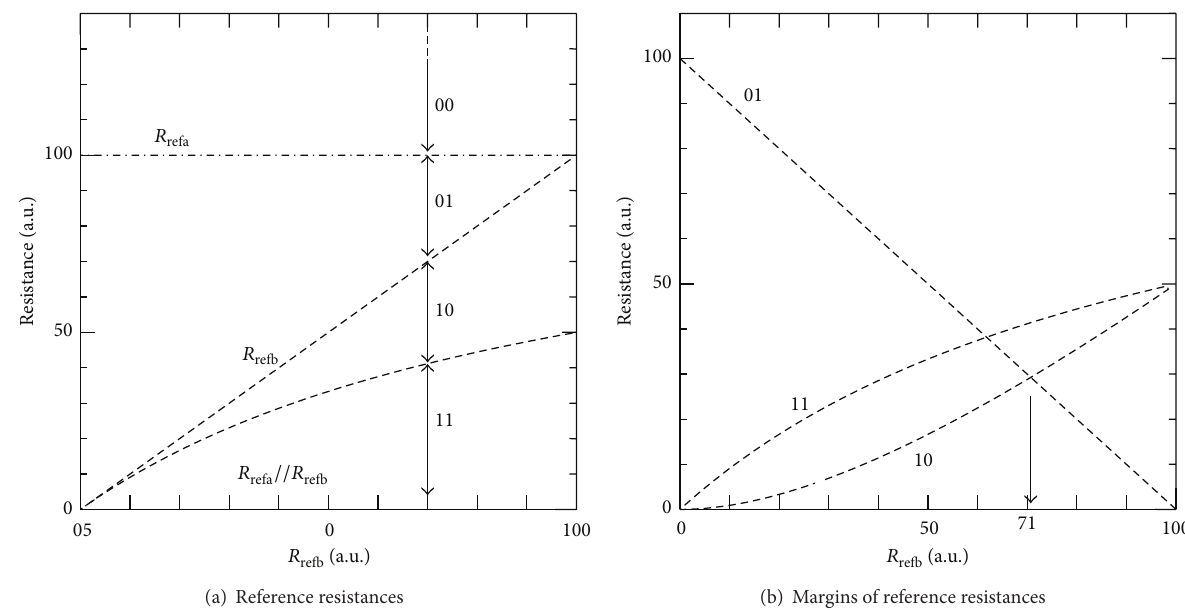
//𝑅 is changed from 0 to 100. 𝑅 shows the parallel resistance of 𝑅 refb refa refb //𝑅 . refa refb